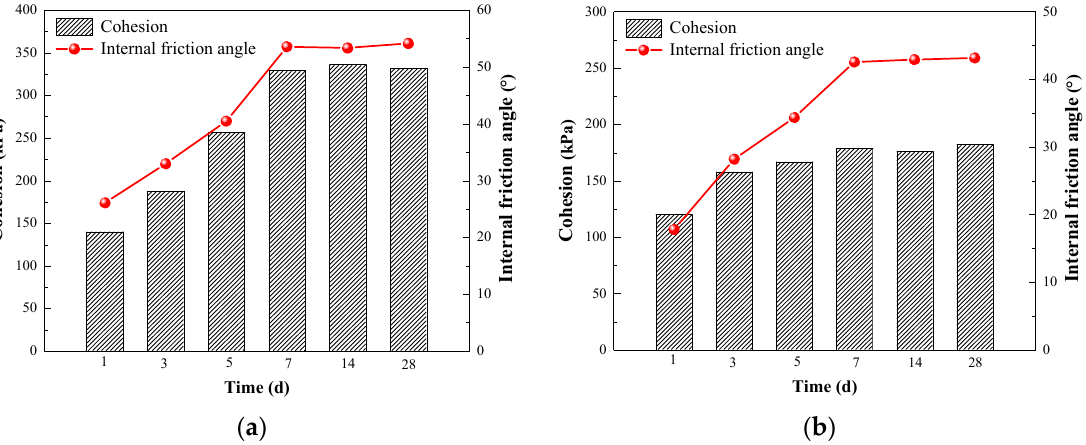
Figure 3. Relationship curve between shear stress and displacement of MS9 modified dredged sludge sample.